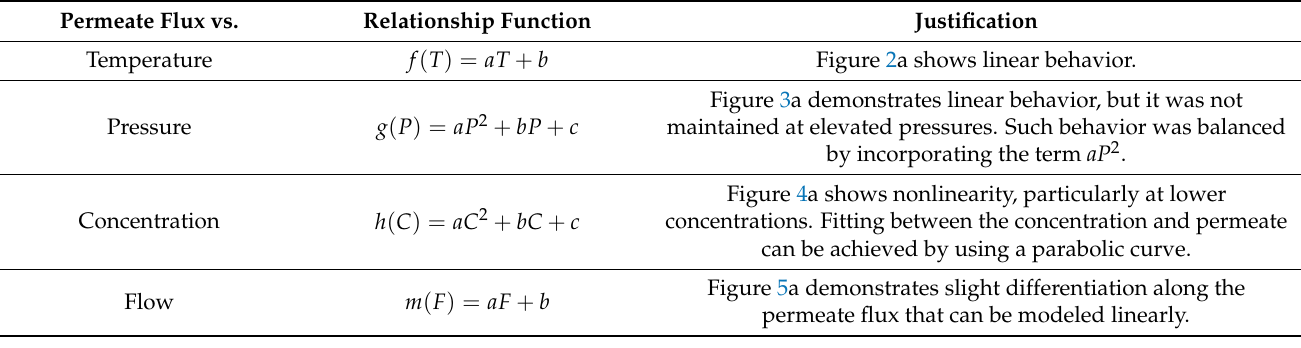
Table 3. Derived functions relating permeate flux with other parameters.